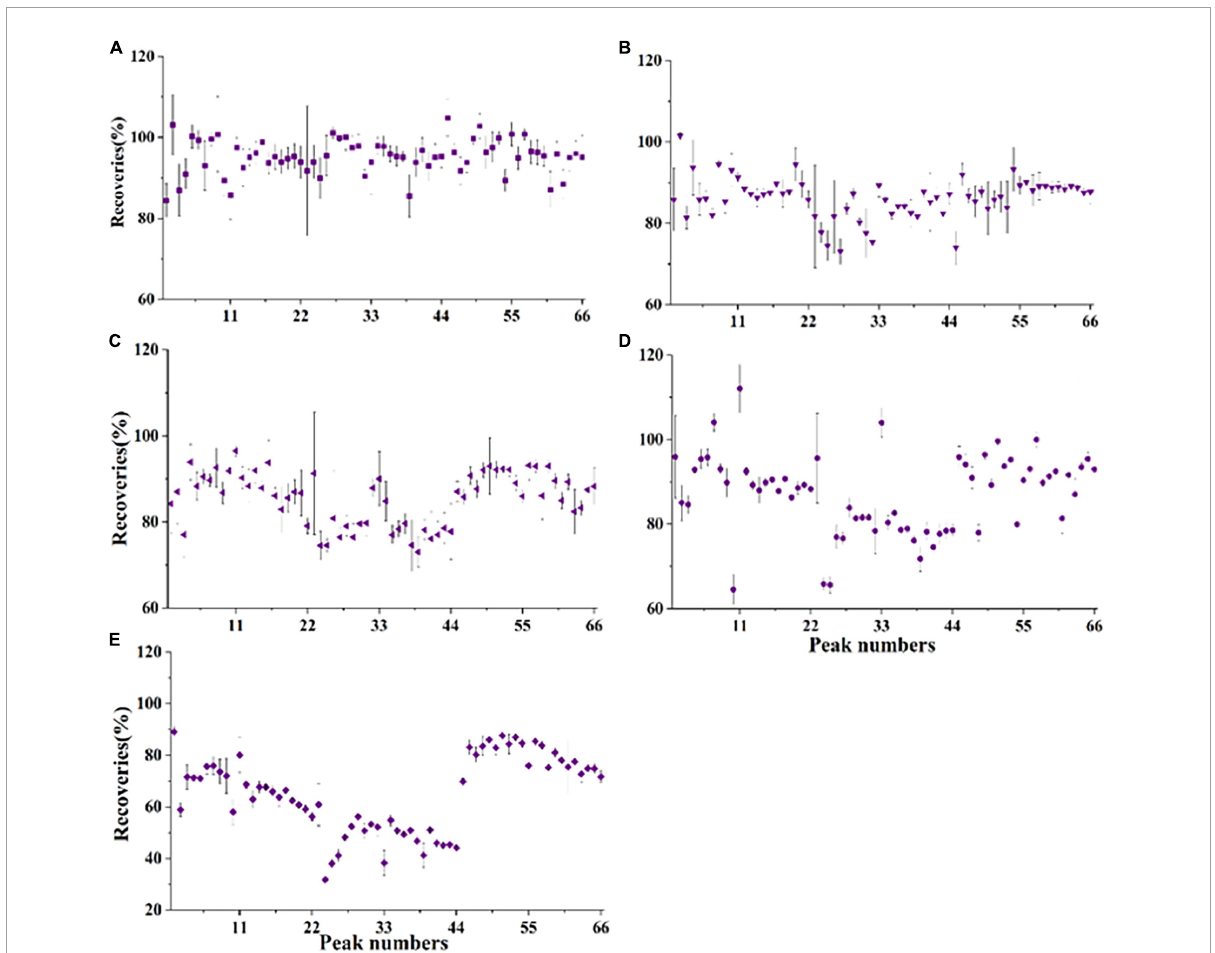
FIGURE4 Recoveries of different dispersive solid-phase extraction (DSPE) sorbents for polyethoxylated tallow amine (POE-tallowamine) homologs in the matrix ( n = 3). The spiked levels were 0.2 mg/L POE-5 and 1 mg/L POE-15. (A) 50 mg PSA, (B) 50 mg C18, (C) 10 mg GCB, (D) 50 mg PSA + 5 mg GCB, and (E) 50 mg PSA + 10 mg GCB. The peak numbers are the same as in Supplementary Table 1